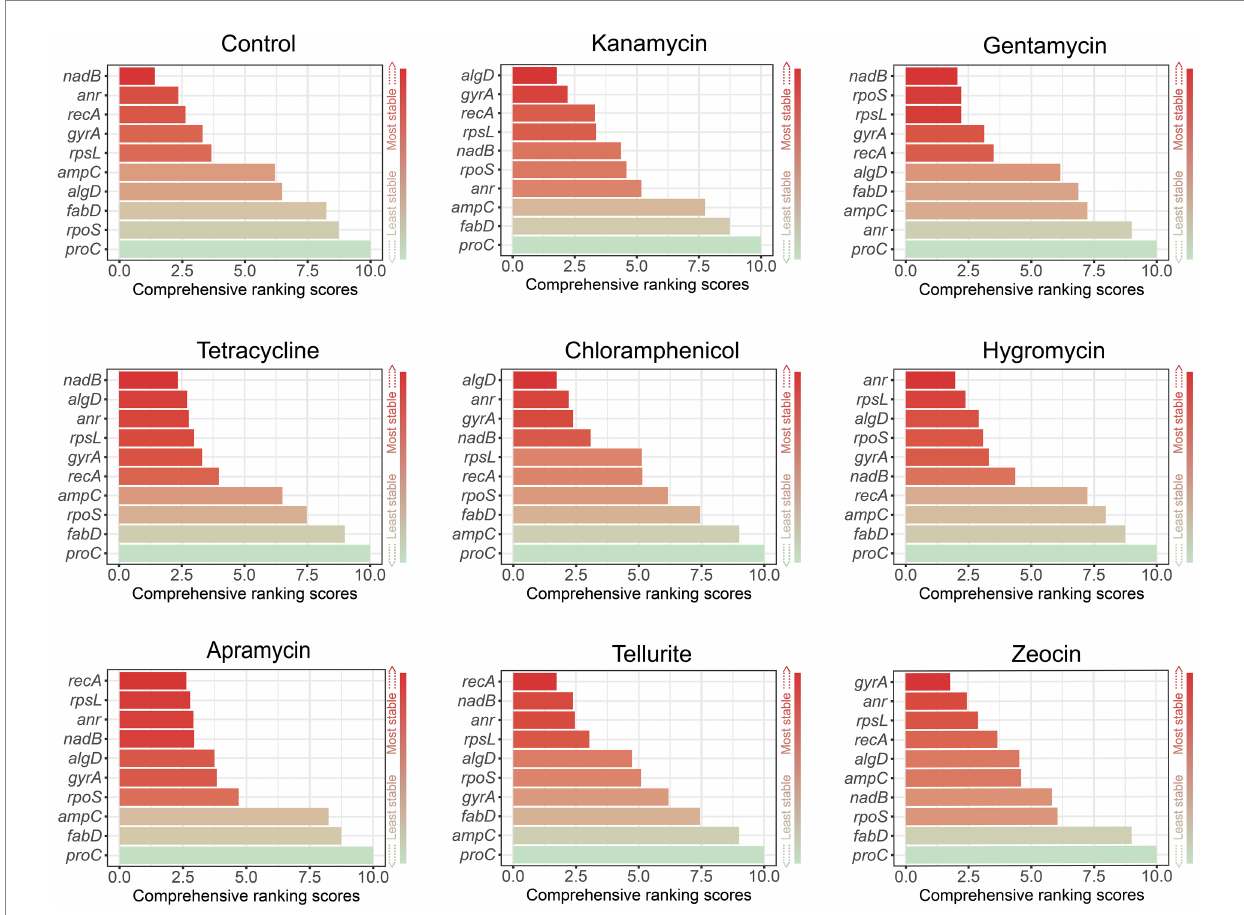
FIGURE 4 Comprehensive ranking by RefFinder according to the results of geNorm, NormFinder, and BestKeeper. Lower scores (red) indicate the higher expression stability.